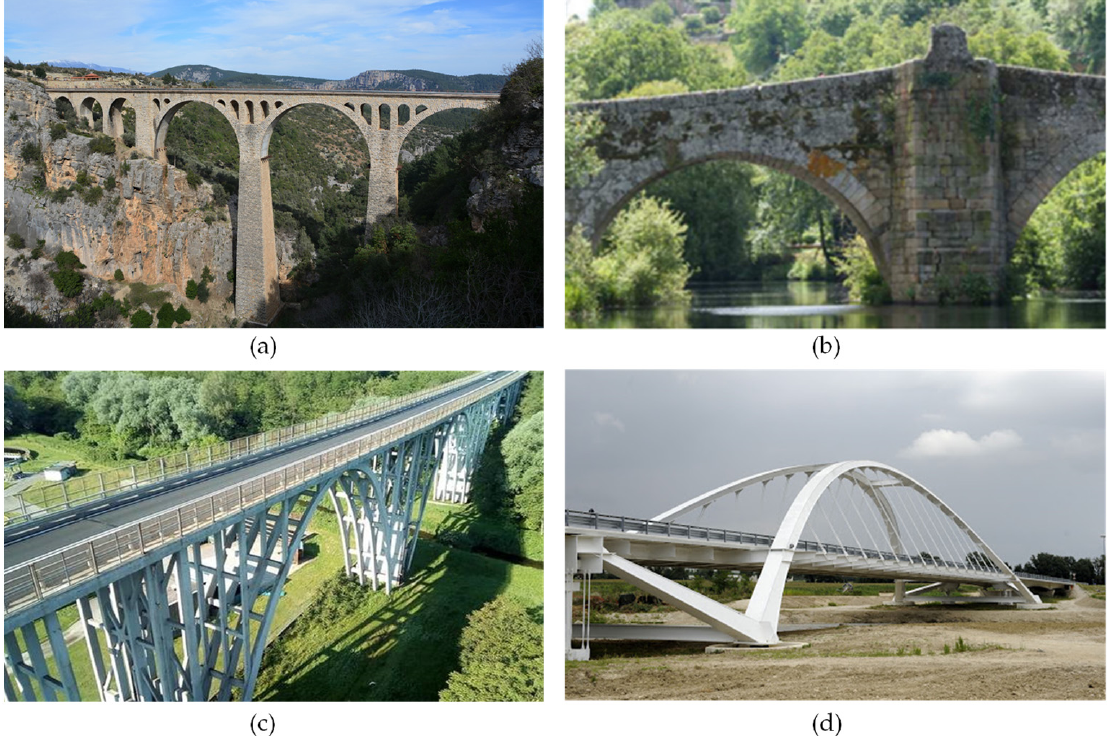
Figure 2. Examples of arch bridges: ( a ) Hacikiri bridge [20]; ( b ) Villanova bridge [21]; ( c ) Viaduct Cairate [22]; ( d ) S. Giovanni Paolo II bridge [23].